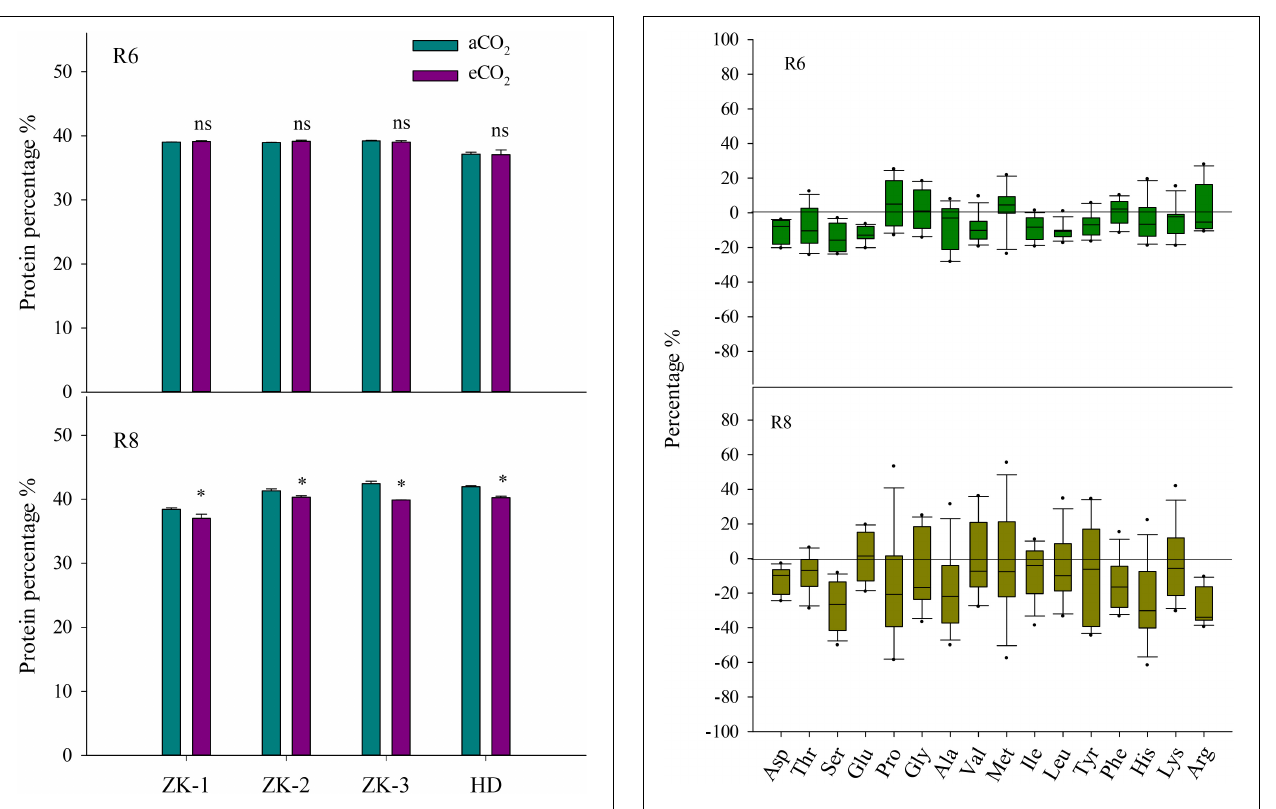
FIGURE 1 | Influence of elevated CO 2 on soybean seed protein concentrations at fresh edible (R6) and mature stages (R8) in the four soybean cultivars: Zhongke-maodou 1(ZK-1), Zhongke-maodou 2 (ZK-2), Zhongke-maodou 3(ZK-3), and Hei-maodou (HD); error bars represent the standard error ( n = 3). Significant differences between CO 2 treatments for each cultivar are noted with an asterisk at P < 0.05.